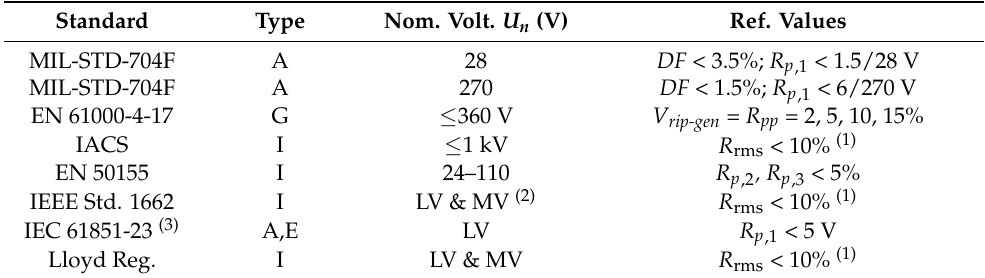
Table 6. Limits and reference values for ripple (voltage ripple, if not otherwise specified) (E = emission, I = immunity, G = generator, A = ambient